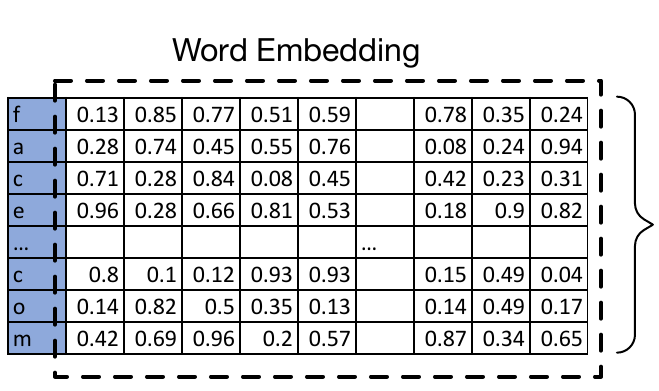
Figure 9. Example of one hot encoding.